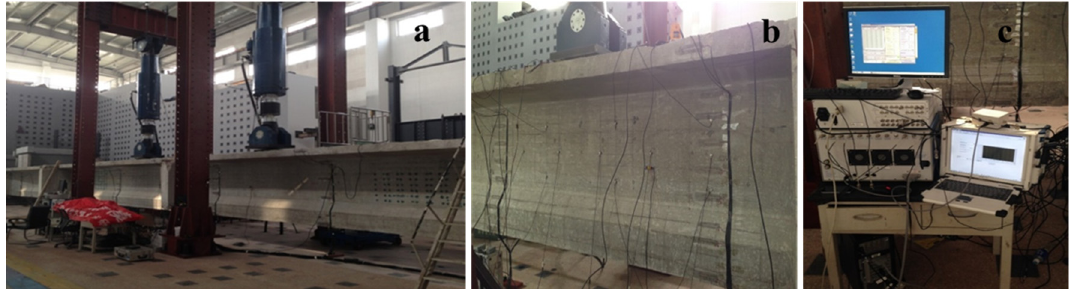
Figure 6. Photographs of ( a ) four bending test, ( b ) transducer and gauge networks, and ( c ) excitation and measurement equipment.